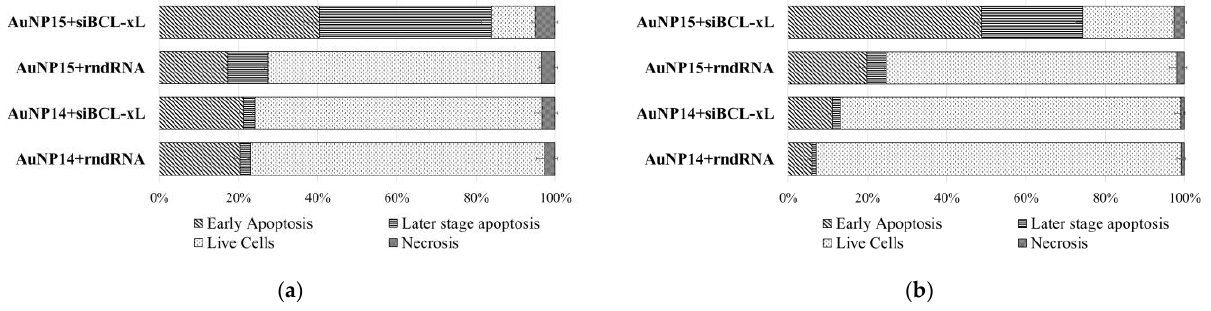
Figure 7. Distribution of ( a ) HL-60 and ( b ) CEM-SS cells by types of cell death among the FAM-positive cells after 48 h incubation. AuNP concentrations correspond to optimal delivery concentrations based on previous calculations (100 µg/mL for AuNP13; 25 µg/mL for AuNP14; 10 µg/mL for AuNP15). Data obtained by flow cytometry. In each repeat at least 7500 events were collected and analyzed.